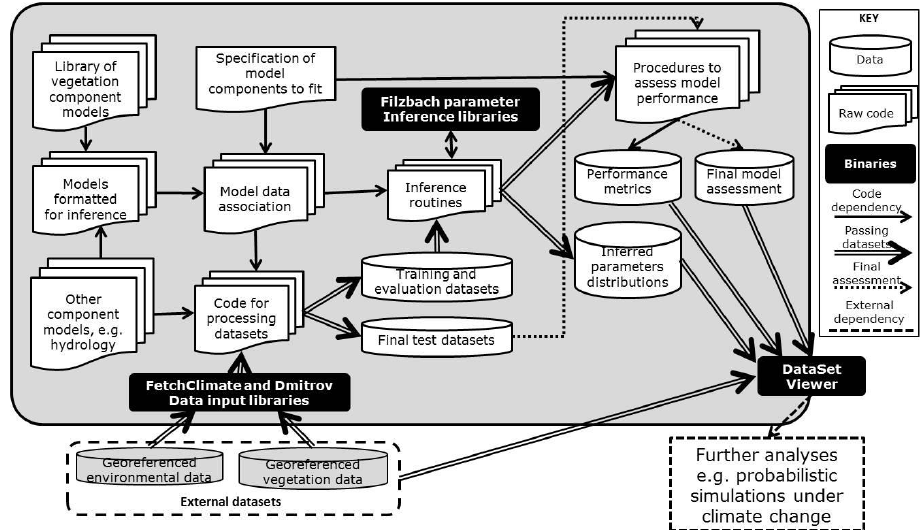
Fig. 2. Our prototype automated system used for the construction, parameter estimation and assessment of multi-component models of arbitrary complexity. This automated system was used to develop and analyse our model. Inputs are multi-component models and empirical data. Data are partitioned into training, evaluation and final test sets. Input libraries provide a common interface to connect code with data. Inference routines use inference libraries to infer parameter probability distributions. Inference libraries implement approximate Bayesian inference using Markov chain Monte Carlo methods with the Metropolis–Hastings algorithm. A data viewer provides a standard interface for inspecting inputs and results. See Sect. 4.1. for details on how to download the